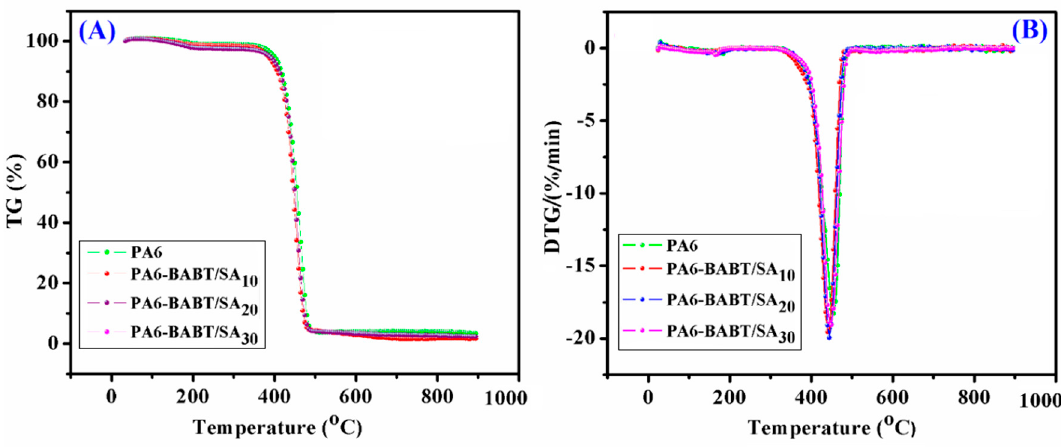
Figure 12. ( A ) TGA of PA6 and PA6-BABT/SA copolyamides. ( B ) DTG (differential thermogravimetric) curves of PA6 and PA6-BABT/SA copolyamides.